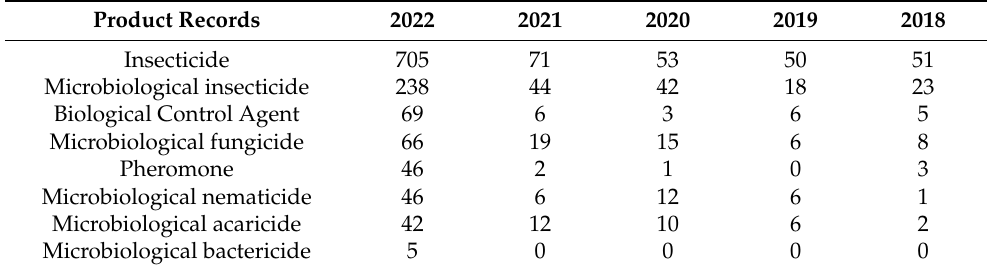
Table 3. Several records of products for arthropod control in